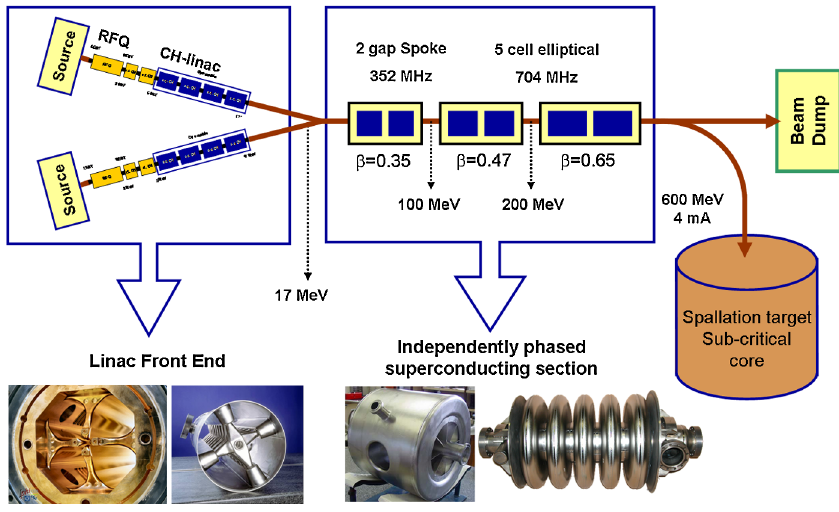
FIG. 10. (Color) Reference design of the 600 MeV EUROTRANS proton driver